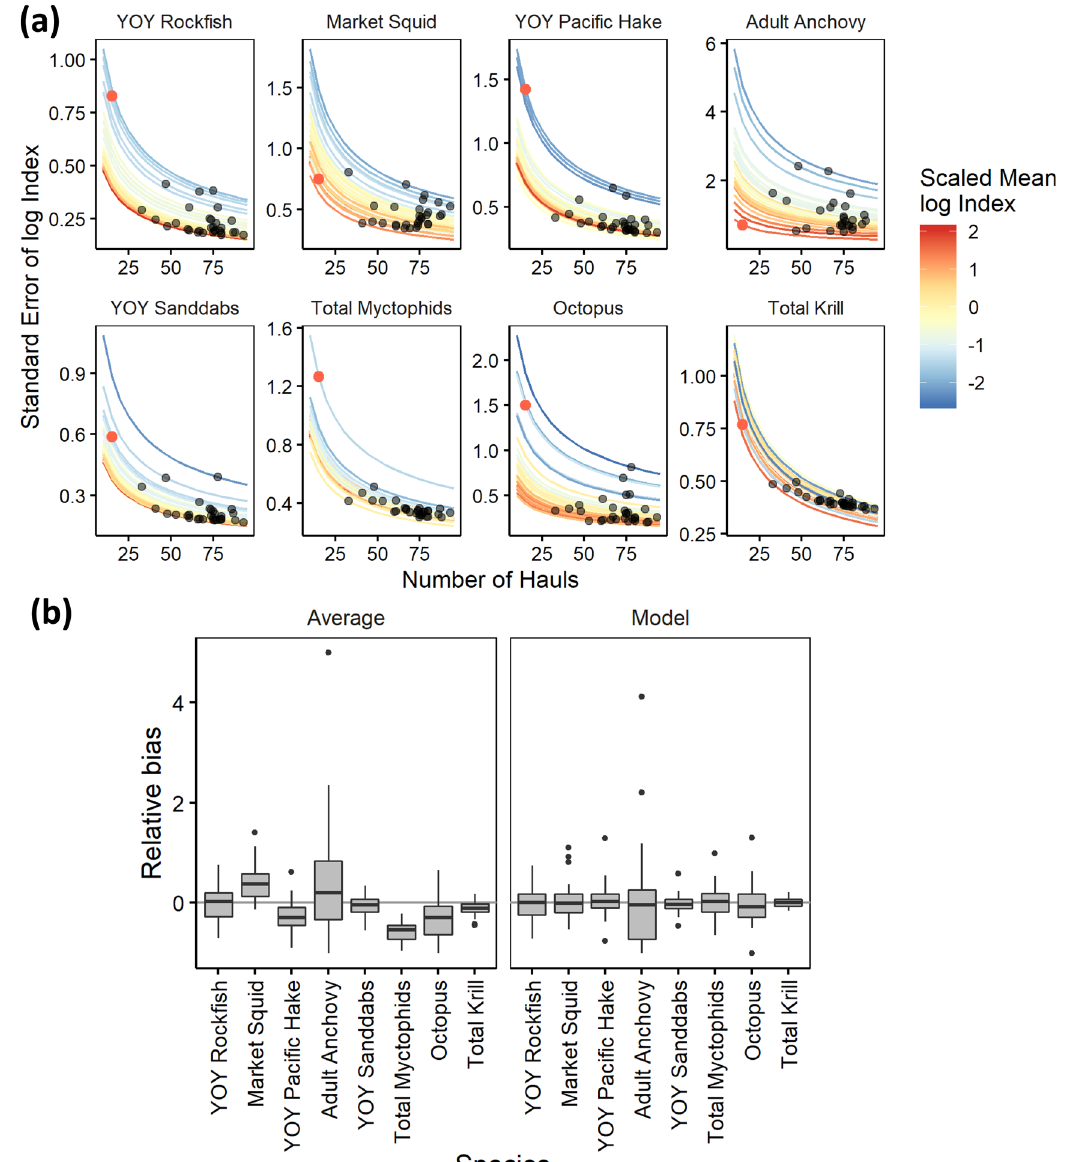
Fig. 2 A model for uncertainty and unavoidable effort reduction. a SE of log index vs. number of hauls for a given year from the delta-GLM model. Each point is a year, with 2020 indicated in red. Lines are predicted relationship between SE and sample size for each year, color indicating the mean log index for that year, scaled within taxa. b Relative bias in the index point estimate using 15 hauls from the 2020 stations vs. all hauls from all stations sampled in a given year, computed as ( x 2020 − x all )/x all . Boxplots show spread of results across all years, 1990 – 2019 ( n = 30 independent years, center: median, box: fi rst and third quartiles, whiskers: smallest and largest values no further than 1.5× IQR from the fi rst and third quartiles; IQR, interquartile range). In the left panel, the index was computed by averaging values of log(CPUE + 1) from all available hauls in a given year. In the right panel, the index was computed from the maximum likelihood estimate (MLE) of a delta-GLM model with spatial covariates, as log(MLE + 1). For the model-based index, the x 2020 estimate excludes hauls from the focal year but includes complete data from all other years. CPUE, catch-per-unit-effort; GLM, generalized linear